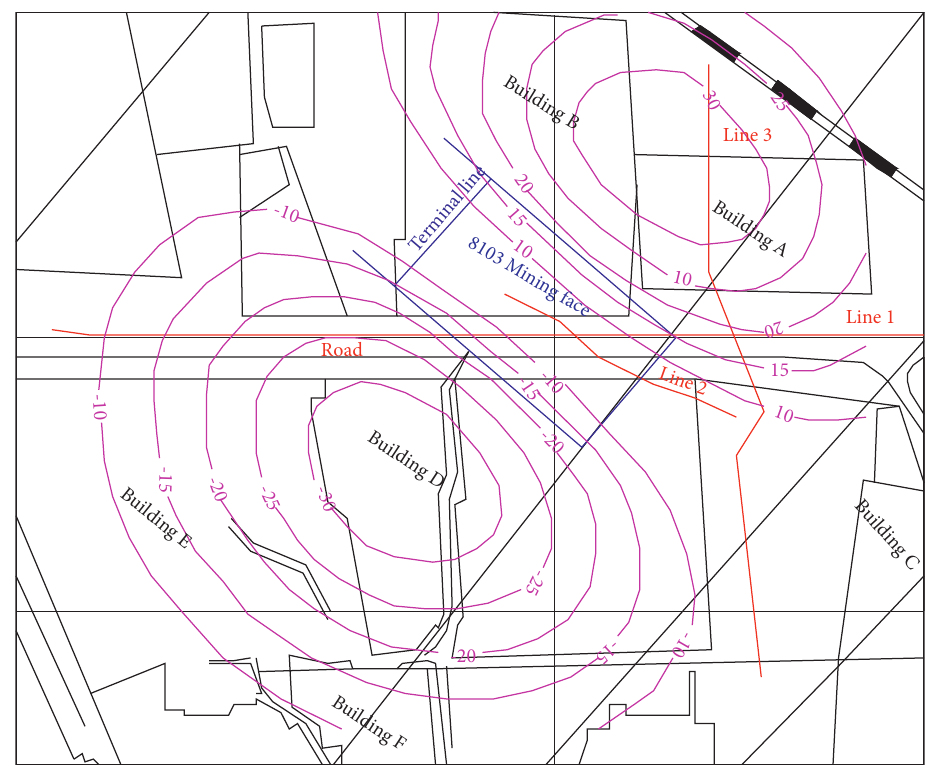
Figure 23: Forecast contour of surface horizontal movement along inclination in 8103 backfilling